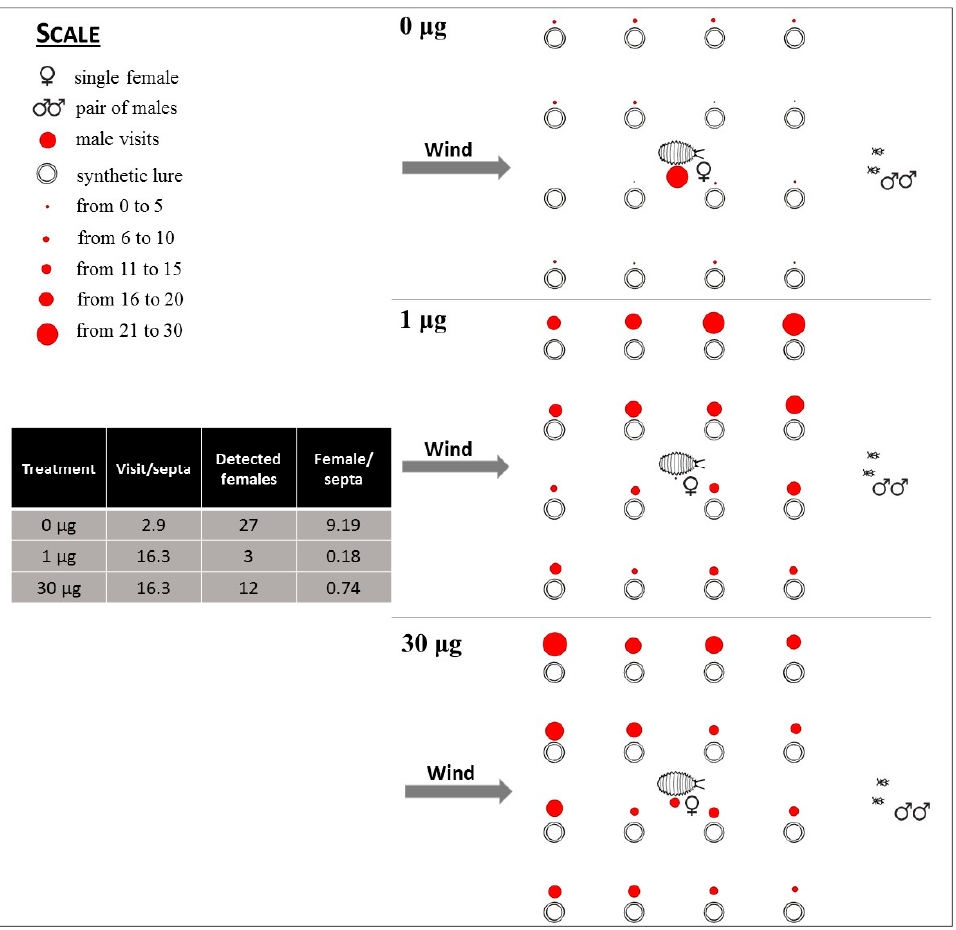
Figure 5. Distribution of visits of P. calceolariae males to the central female and to the 16 surrounding lures loaded with 0, 1, and 30 µ g of synthetic sex pheromone. The diameter of spots represents the number of visits to each lure during 30 replicates, with two males released in each.